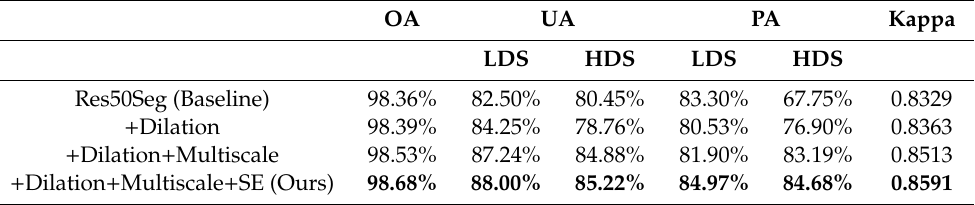
Table 4. Model comparisons with baseline, where values in bold are the